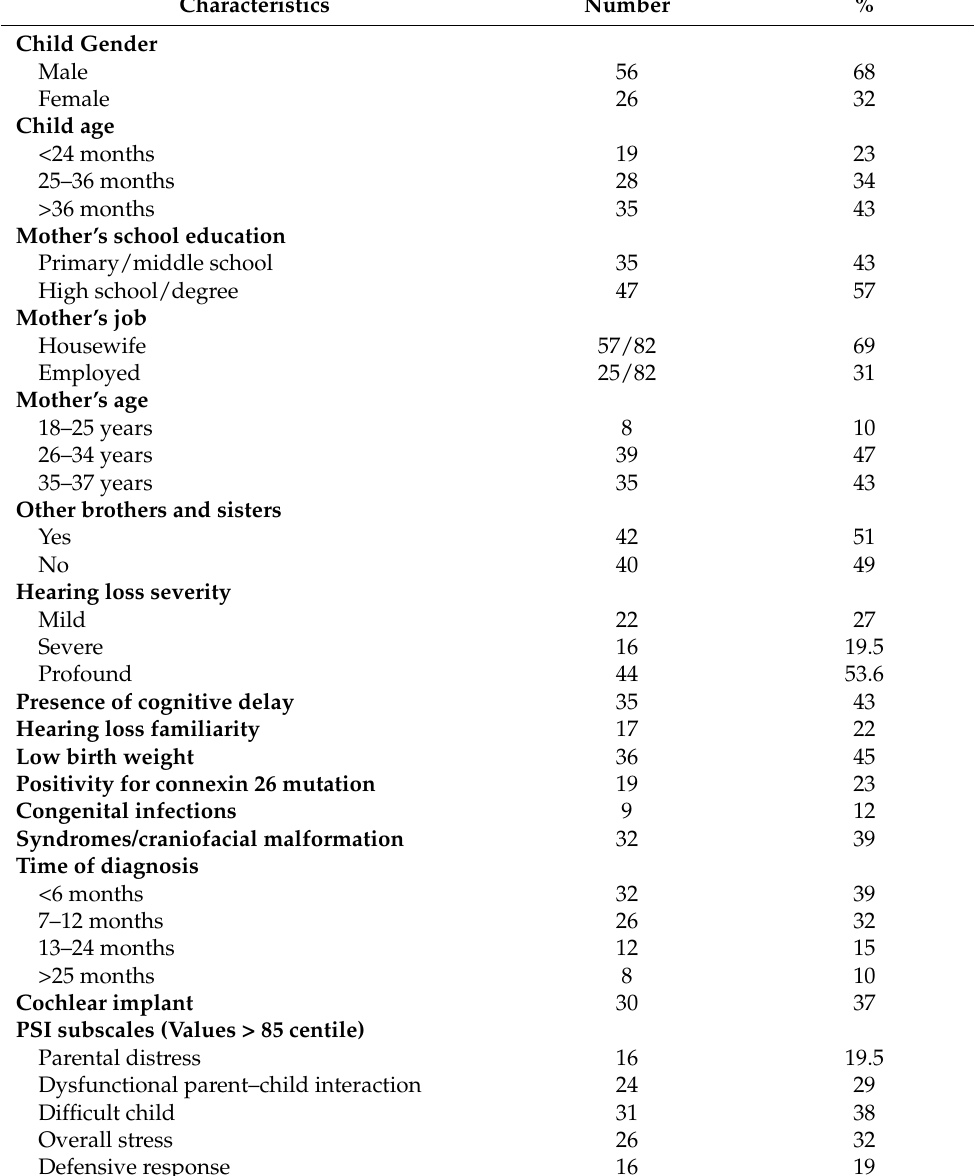
Table 1. Characteristics of subjects